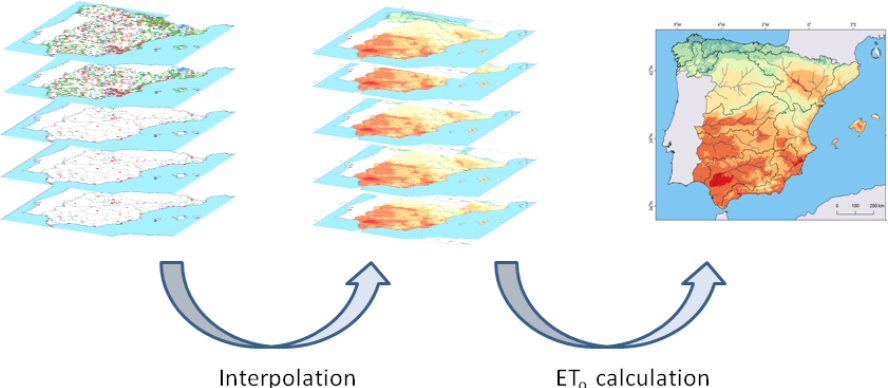
Figure 2. Main steps involved in generating the ET o database. First, we interpolated each climatic variable then calculated ET o .